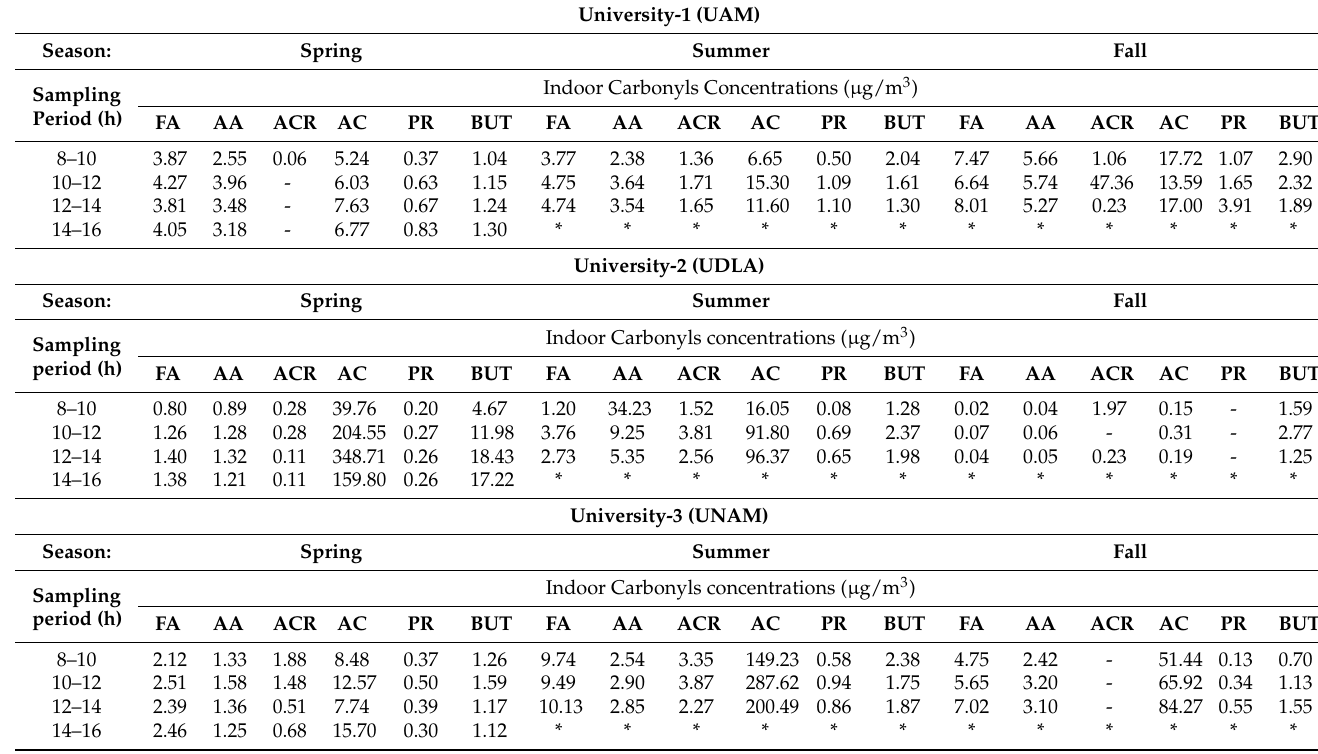
Table 5. Diurnal variation of carbonyl indoor concentrations at the three sampling sites (University-1 UAM, University-2 UDLA and University-3 UNAM) during the three sampling